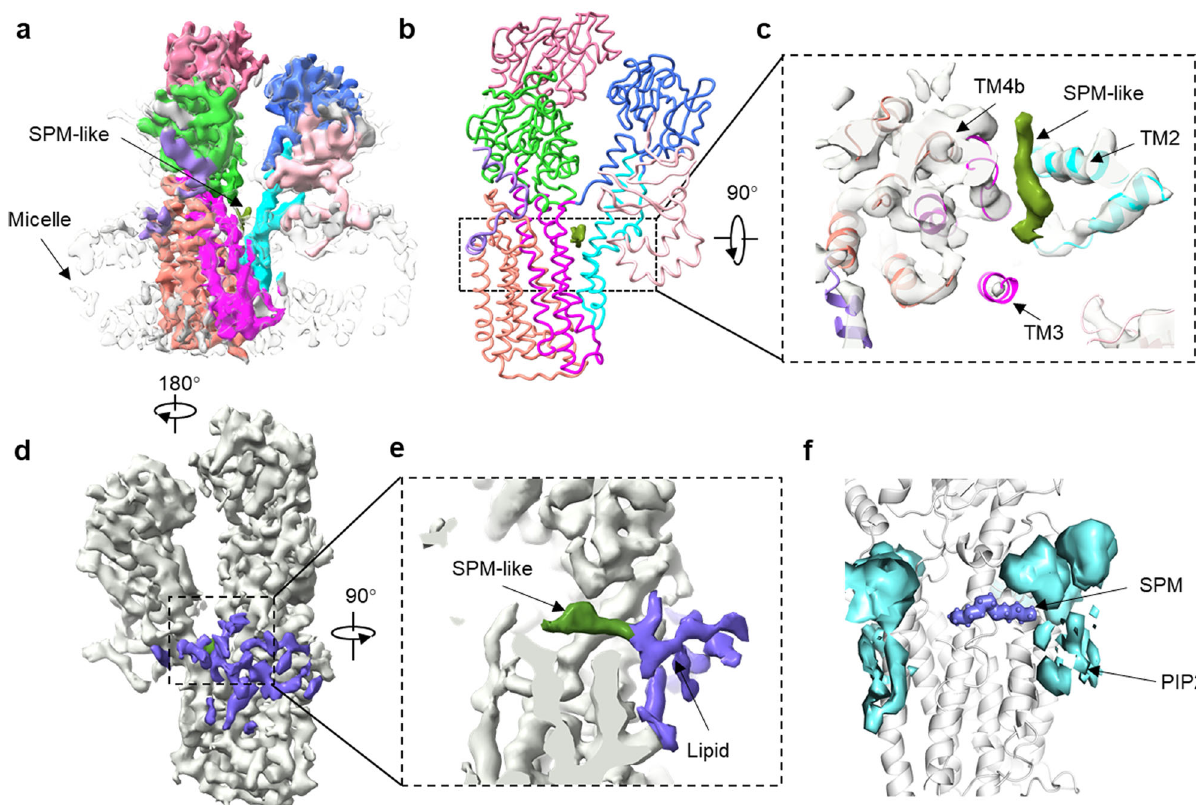
Fig. 4 | Structural analysis of hATP13A2 in the putative E2 state. a Cryo-EM density representation of polyamine released. SPM-like density is shown with smudge. The micelle density is shown as gray. b , c The EM density of SPM in the putativeE2stateisshownasChimeraX ’ s “ solid ” (smudge)representation( b ),anda 90° rotation of the structure reveals the putative substrate-releasing pathway